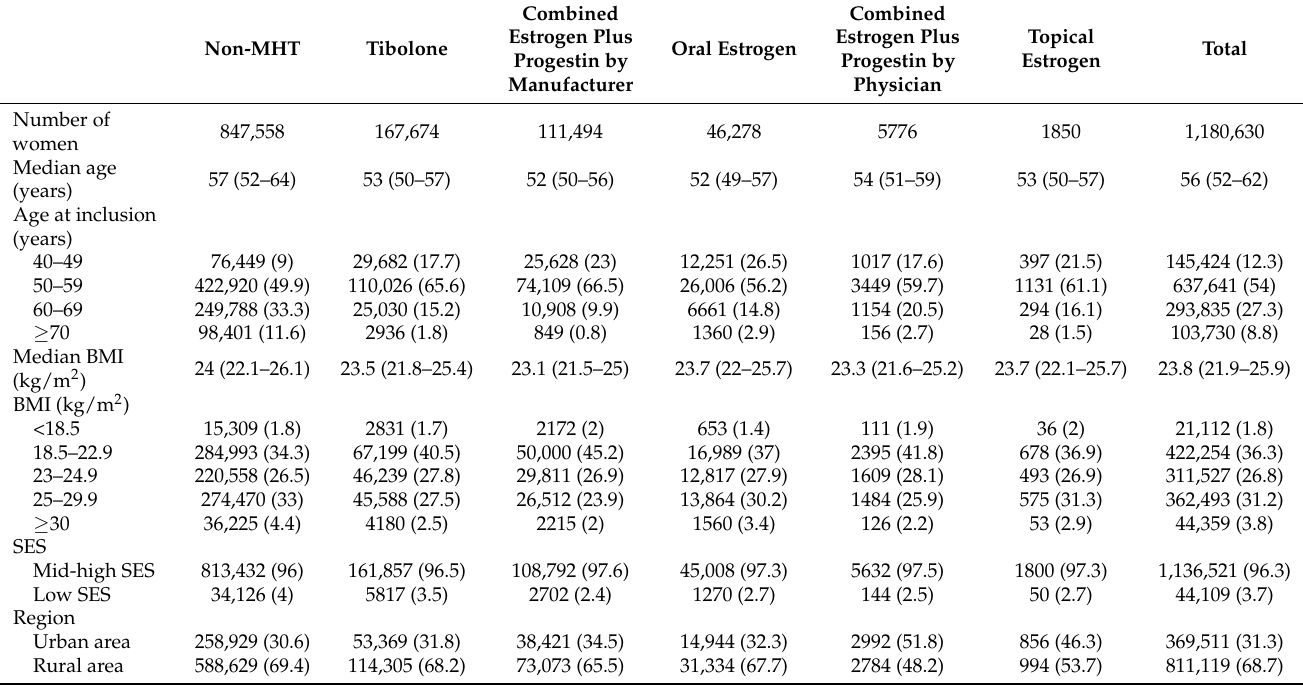
Table 1. Characteristics of women according to menopausal hormone exposure status at recruitment, Korea National Health Insurance Data, 2002–2019.